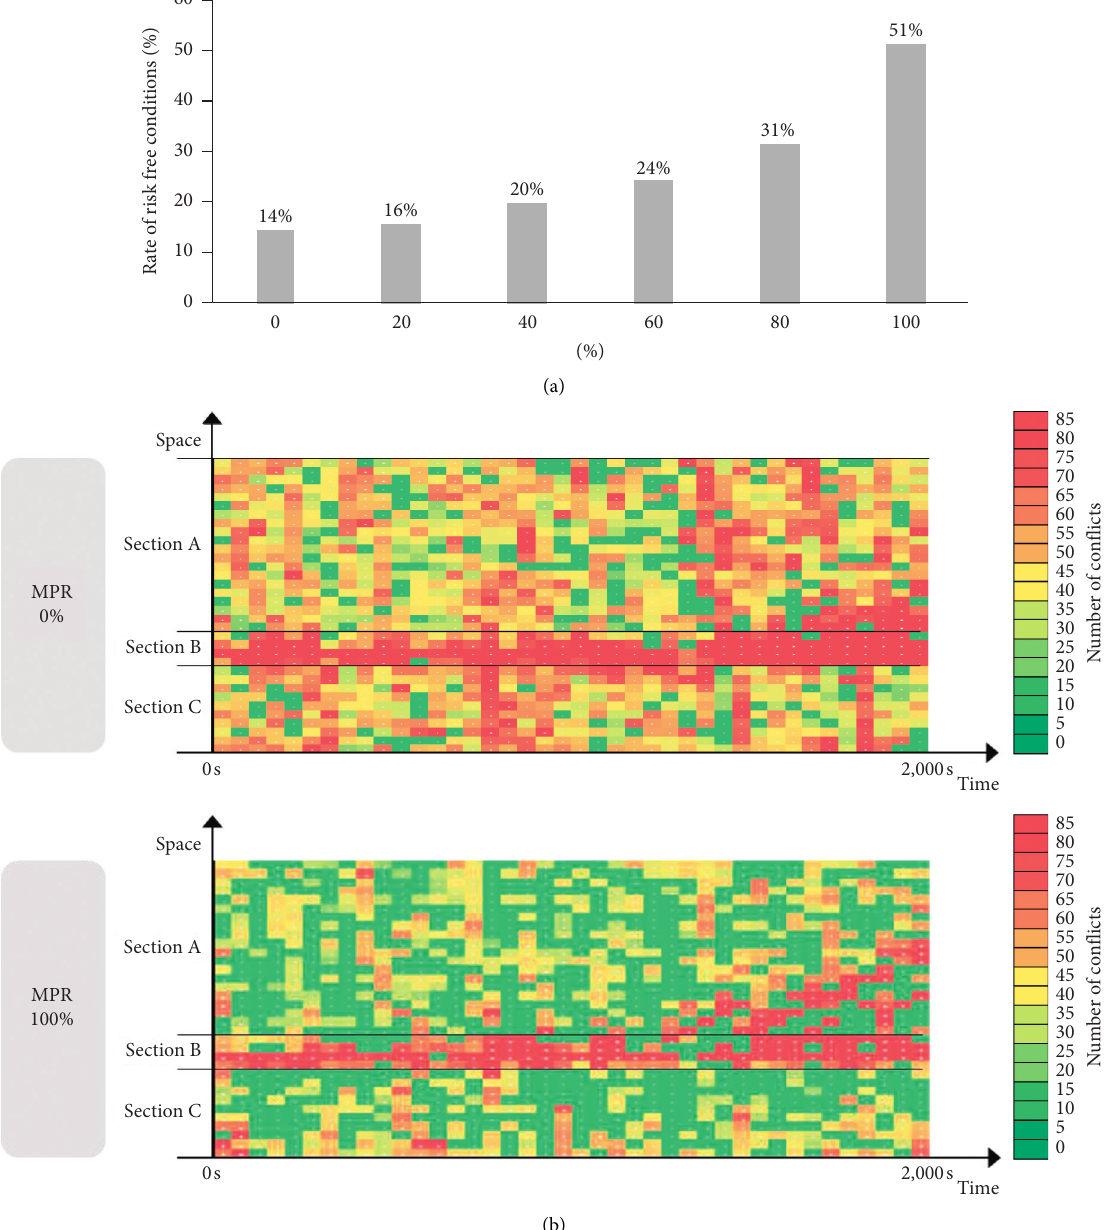
Figure 4: Analysis results of rear-end conflict. (a) Rate of risk-free conditions by MPR and (b) spatiotemporal diagram of conflicts by MPR 0%,